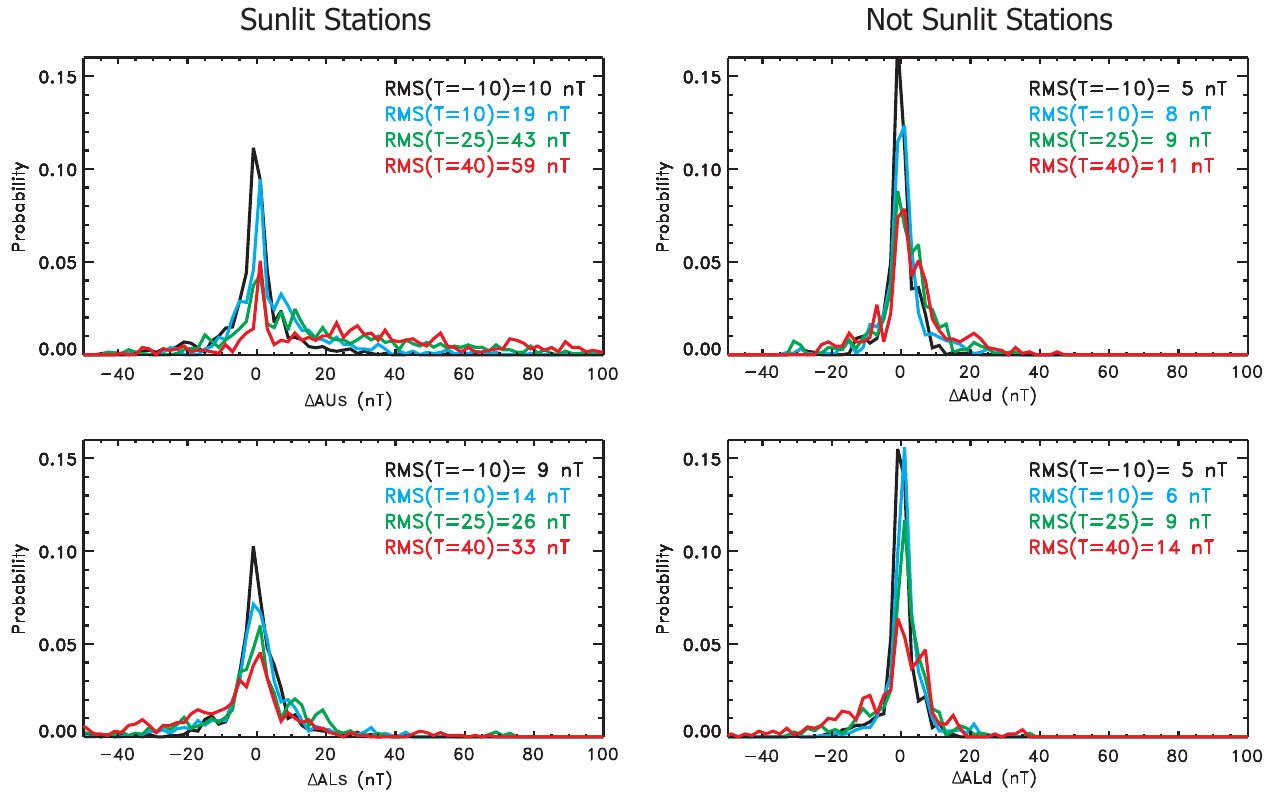
Fig. 5. Normalized distributions of 1 AUs, 1 AUd, 1 ALs and 1 AUd shown in Fig. 4 at four timestamps, T =[ − 10, 10, 25, 40]. Root-mean- square is indicated as